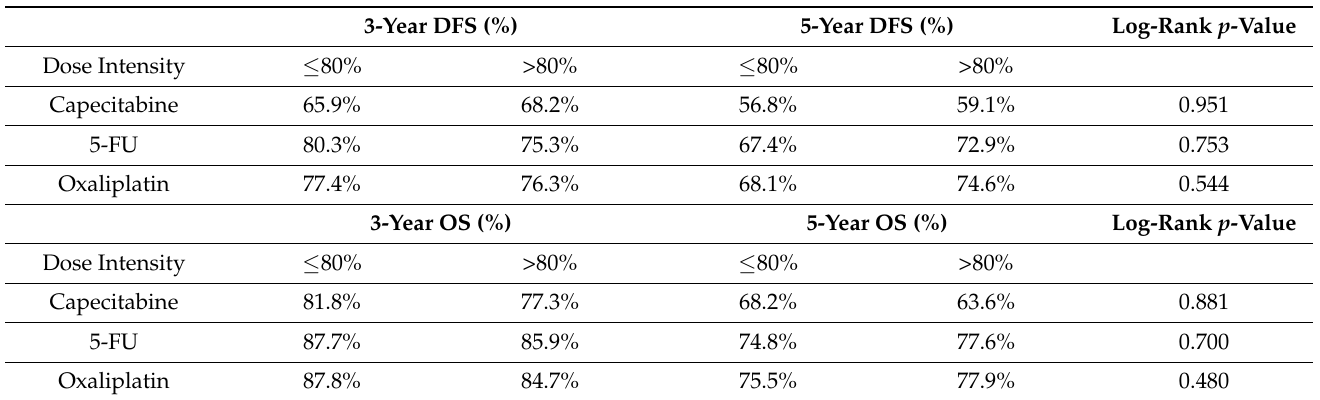
Table 2. The 3 and 5-year DFS and OS stratified by DI of capecitabine, 5-FU and